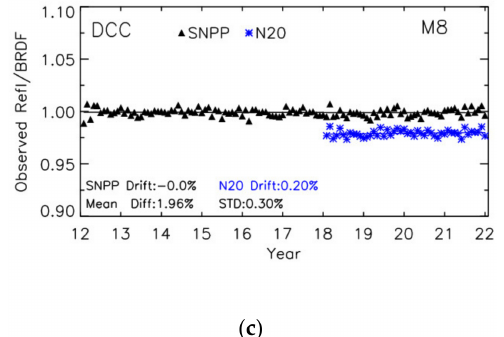
Figure 6. Normalized reflectance trends for SNPP and NOAA20 VIIRS M8 obtained from the Libya-4 ( a ), SNO with Aqua MODIS ( b ), and DCC ( c ). Table 3 lists results of the stability assessment for SNPP VIIRS. Over a ten-year mission period, SNPP VIIRS reflectances show a stability of within 1% for all bands, except for a